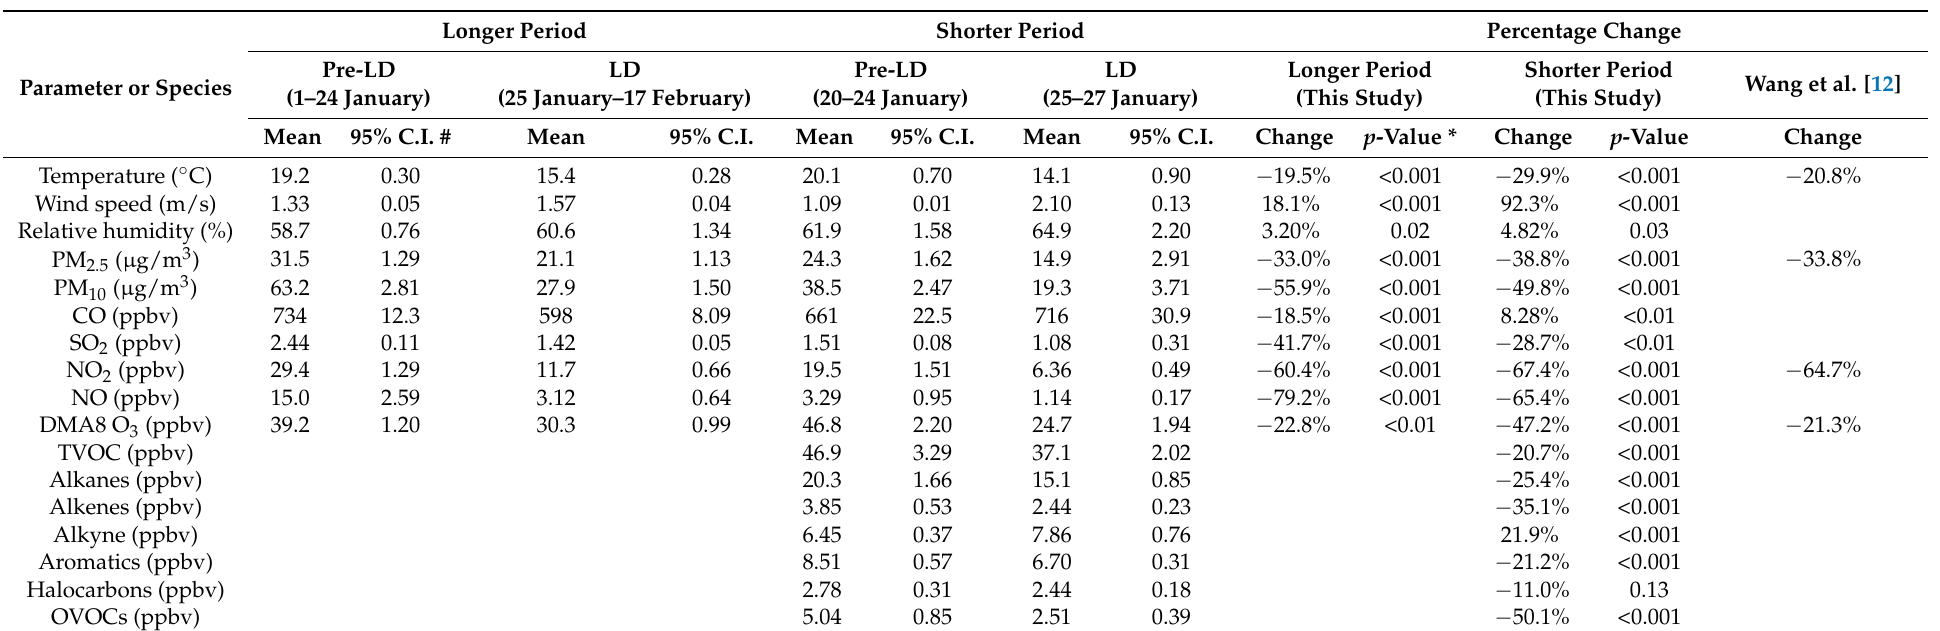
Table 2. Changes in meteorological conditions and concentrations (or mixing ratios) of air pollutants between the Pre-LD and LD periods. Blanks represent uncalculated